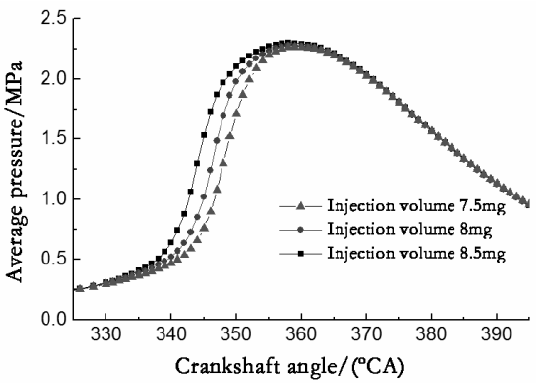
Figure 21. Average pressure in the cylinder with different injection volumes.